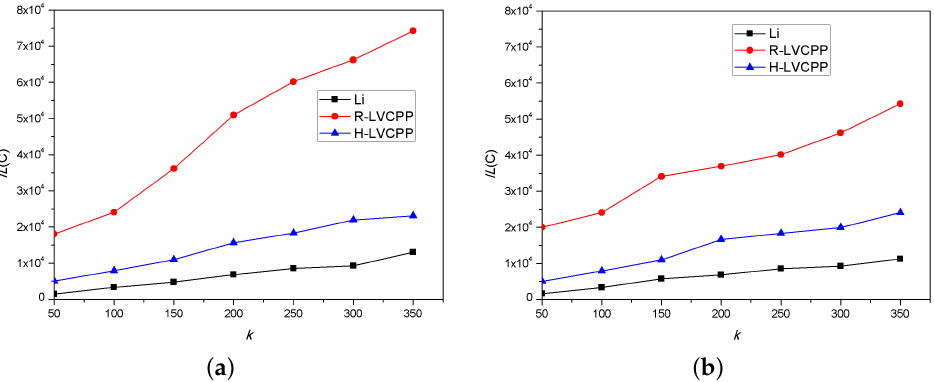
Figure 6. Check-in loss evaluation under different k : ( a ) Brightkite; ( b ) Gowalla. Pattern loss evaluation. The pattern loss of the user visiting mode is shown in Figure 7.